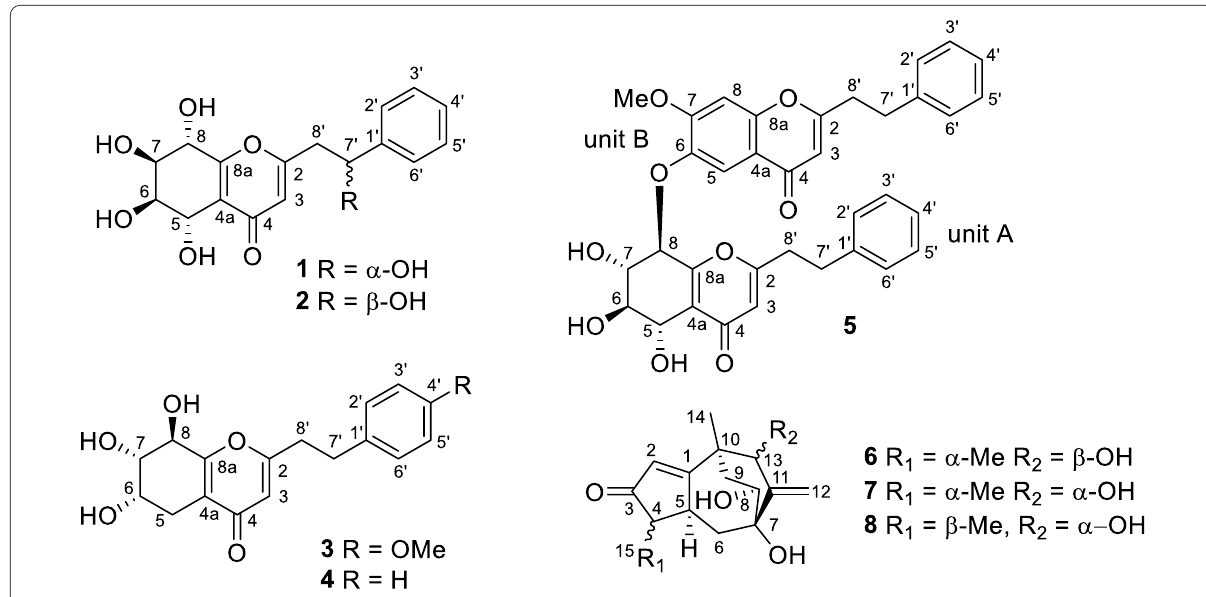
Fig. 1 Chemical structures of compounds 1 – 8 from Aquilaria